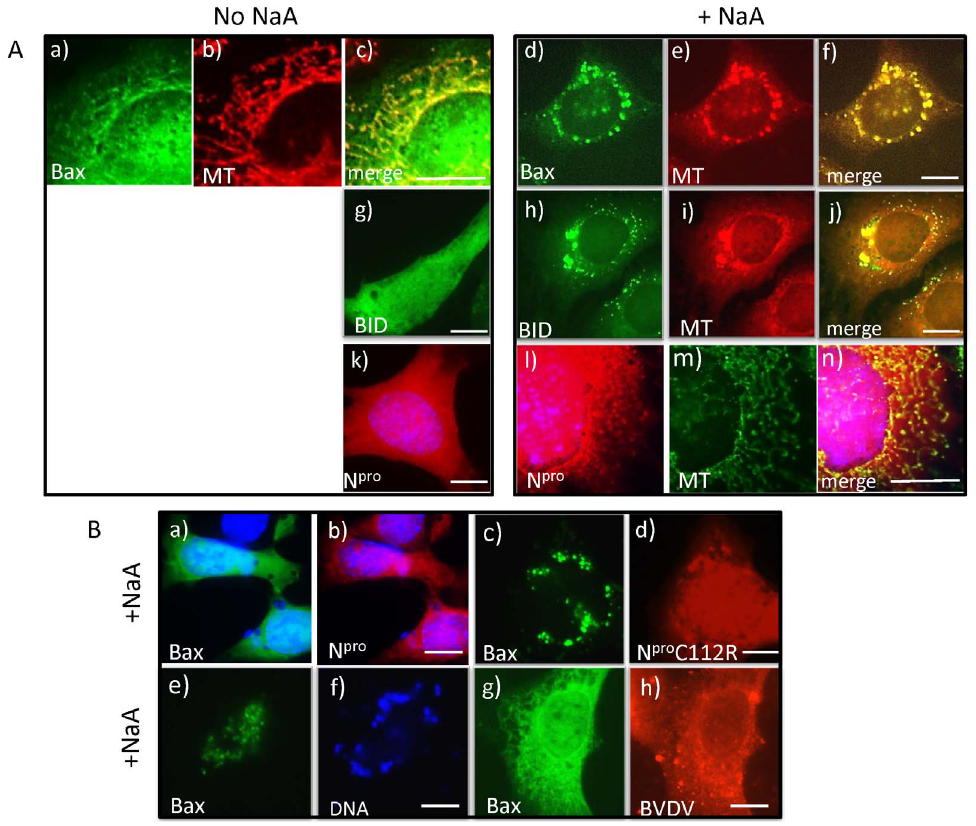
Figure 2. N pro is recruited to mitochondria after cell stress and protects from apoptosis. (A). MEF cells were transfected with Bax-GFP alone (a–f) or tBid-GFP alone (g–j) or N pro cherry alone (k–n) and either untreated (No NaA, left panel) or treated with sodium arsenate for 4 hours ( + NaA, right panel). Cells were incubated with Mitotracker (MT) CM Ros (b,e,i) or Green FM (m) for 30 mins before fixation. (B). Protection from apoptosis induced by sodium arsenate requires IRF3. MEF cells co-expresssing Bax-GFP and either wild type N pro -cherry (a–b) or mutant N pro C112R- cherry (c–d) were treated with sodium arsenate ( + NaA). MDBK primary cells, transfected with Bax GFP (e–f) alone or infected with BVDV overnight and then transfected with Bax GFP (g–h), were treated with sodium arsenate ( + NaA) for 4 hours. BVDV was detected with bovine hyperimmune serum